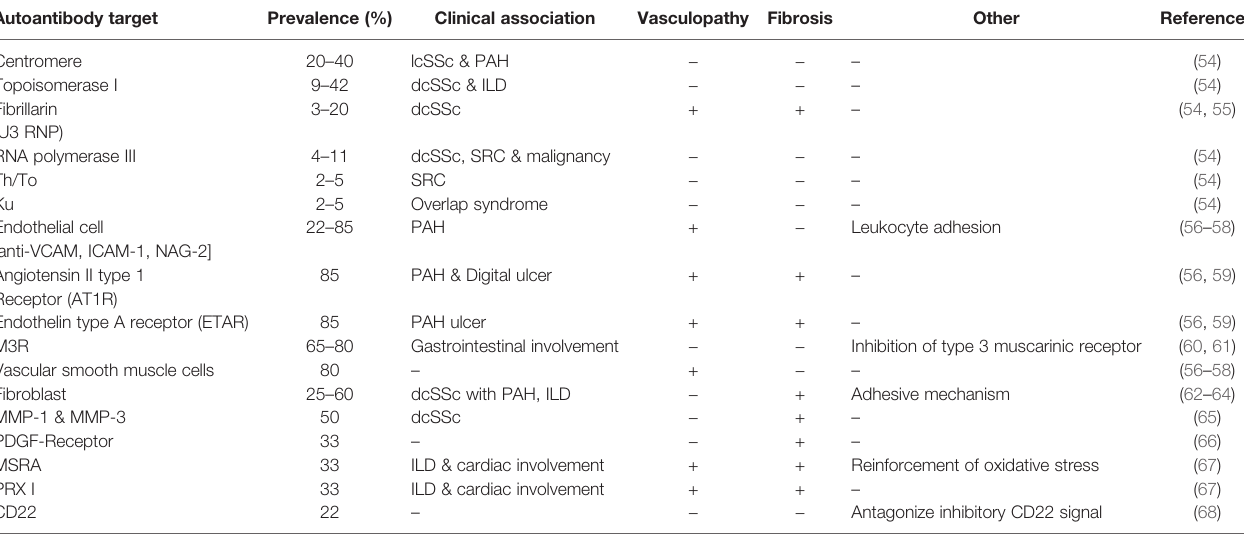
TABLE 1 | Autoantibodies associated with Systemic